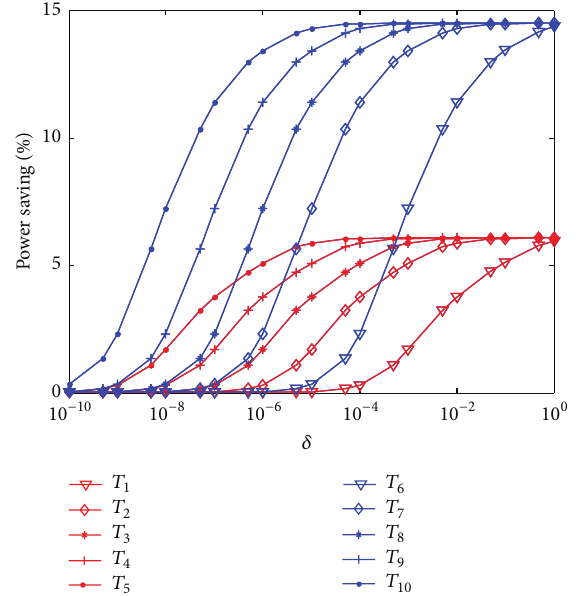
Figure 11: Power saving versus 𝛿 parameter.